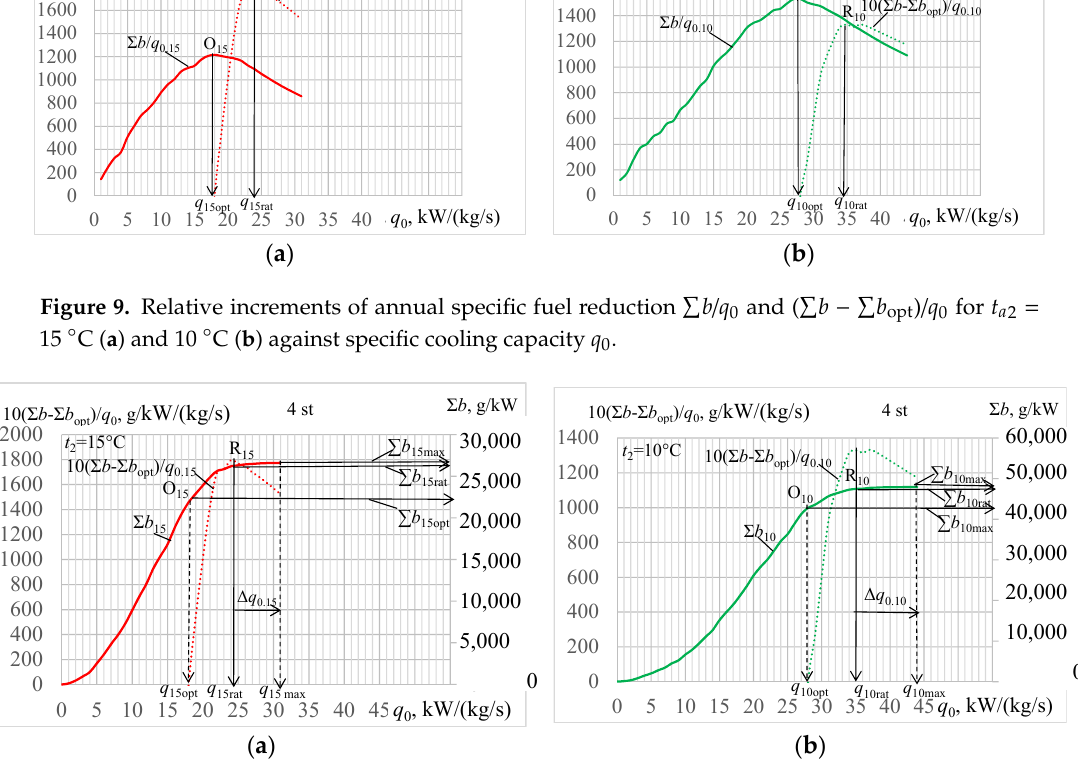
(cid:80) b and relative increment of annual specific fuel reduction (cid:80) (cid:80) b − b opt ) / q 0 . Energies 2020 , 13 , x FOR PEER REVIEW